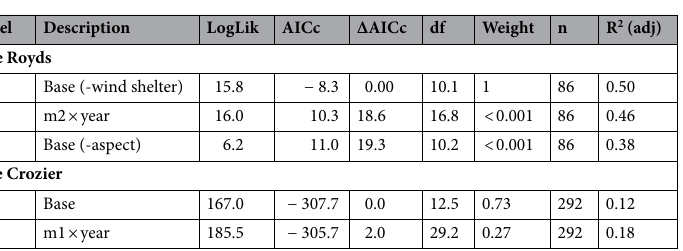
Table 3. Generalized additive models of spatial variability in reproductive success for Cape Crozier and Cape Royds, Ross Island, Antarctica, 2014–2017. The base model was a model that initially (prior to automatic variable selection) included all covariates but no year interactions. Covariates are listed below the table. Models were ranked and weighted by Akaike’s information criterion corrected for small sample sizes (AICc; n/df < 40). Base model: area + perimeter-area ratio + aspect + slope + flow accumulation + wind shelter index + elevation + skua within 50 m. Year interaction model : area + perimeter-area ratio + (aspect × year) + (slope × year) + (flow accumulation × year) + (wind shelter index × year) + (skua ×